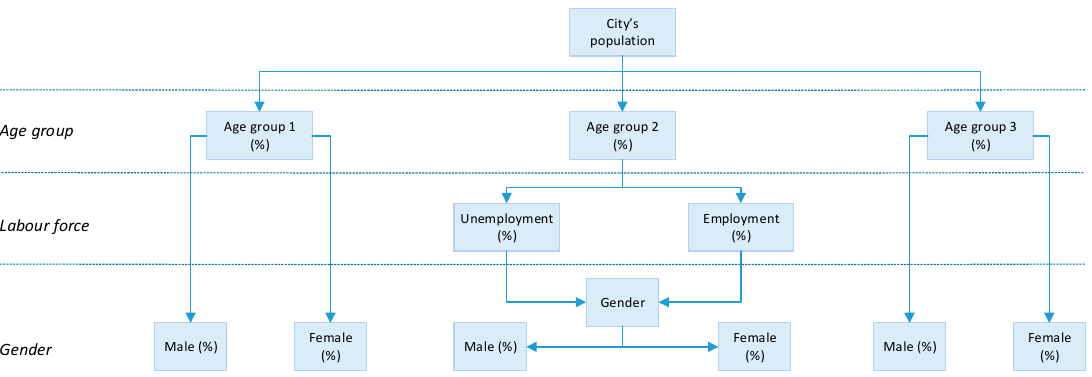
Figure 1. Weighted proportion structure of the city’s main parameters: age group, labour force composition and gender structure.